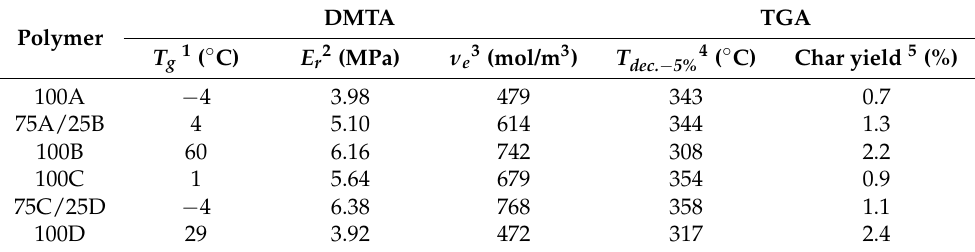
Table 4. Dynamic mechanical thermal analysis (DMTA) and thermogravimetric analysis (TGA) data.